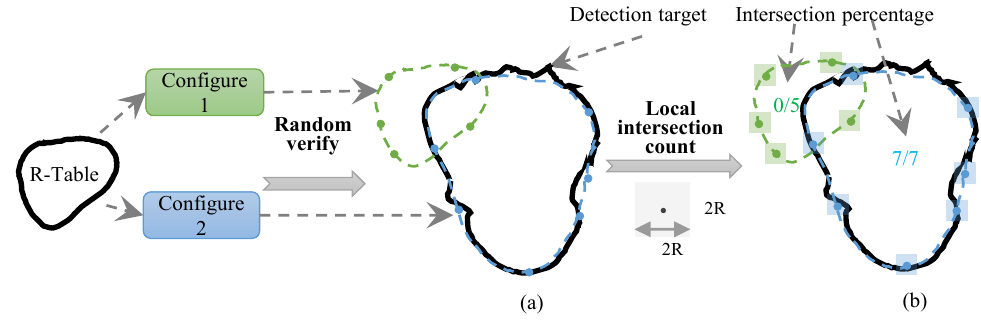
Figure 5. Diagram for the random verify. The green and blue dashed lines in ( a , b ) are the fully back-projected shape for Configurations 1 and 2. For the random verify, the configurations are projected back onto the target image with some random rows in the R-Table, so there are some random points that correspond to Configurations 1 and 2 in ( a ). Then, an intersection percentage of each configuration can be calculated with an expanded range for each point, as shown in ( b